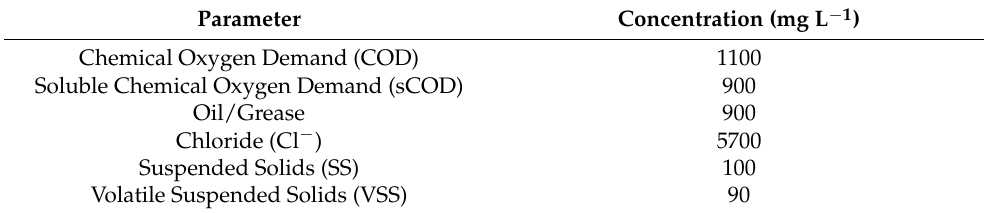
Table 1. Bilge water